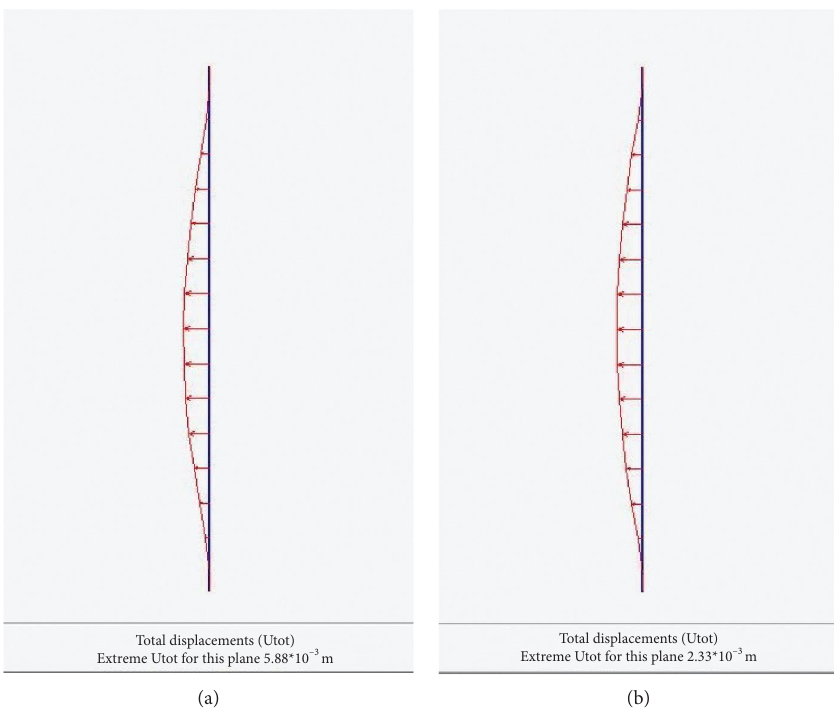
Figure 18: δ max in case of Hp � 20cm, L � B cm and Hp � 20cm, L � 4B/3 cm,